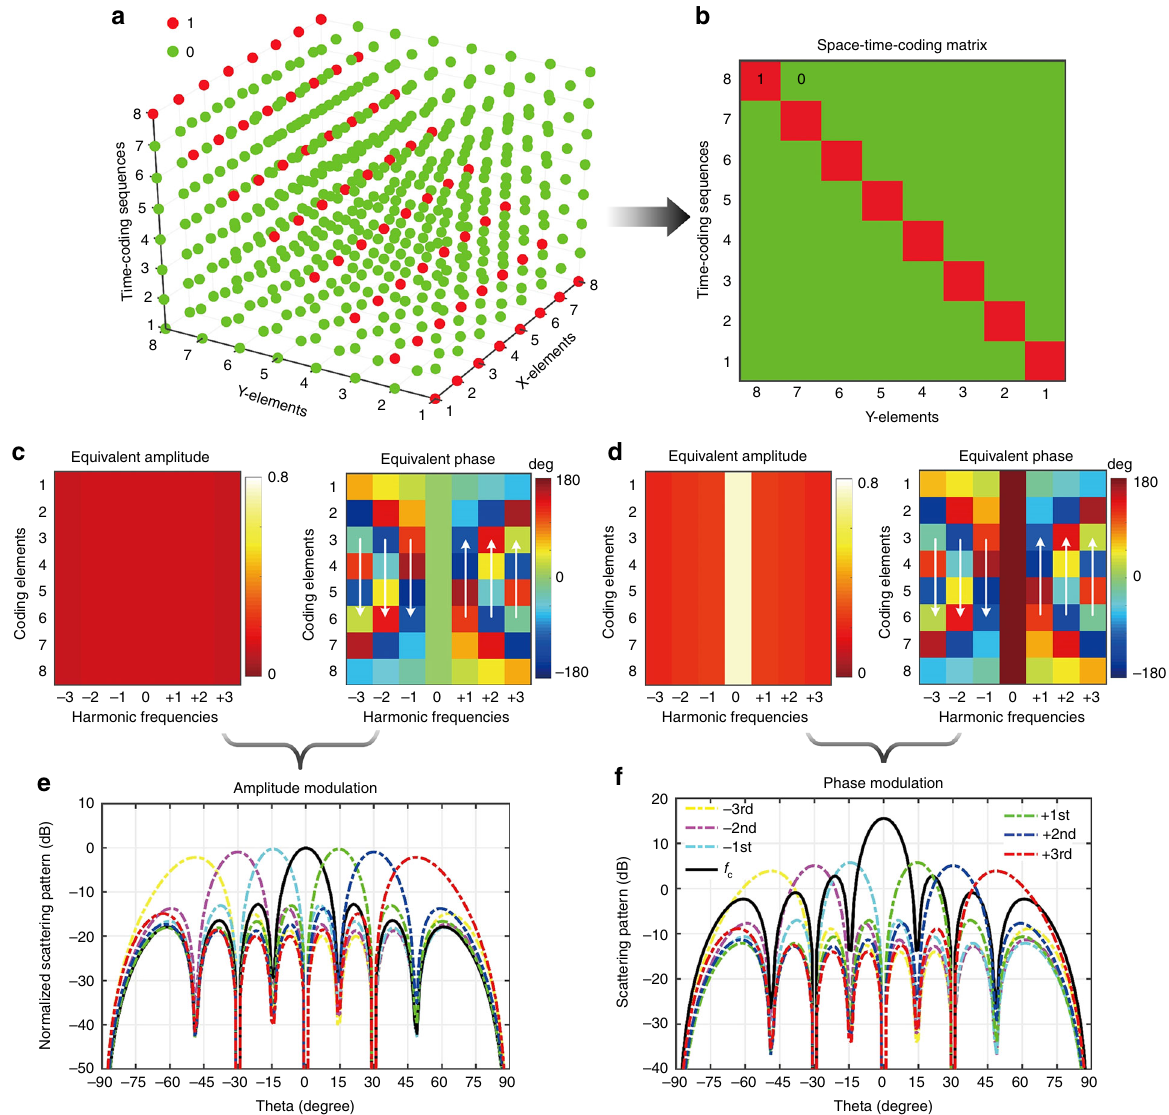
Fig. 2 Harmonic beam steering. a , b 3D space-time-coding matrix and corresponding 2D coding matrix, respectively. The red and green dots represent “ 1 ” and “ 0 ” digits, respectively. c , d Equivalent amplitude and phase distributions pertaining to AM and PM schemes, respectively. The white arrows indicate the phase gradients that emerge at the various harmonic frequencies. e , f Corresponding 1D scattering pattern cuts (at φ = 90°) at different harmonic frequencies pertaining to AM and PM schemes,